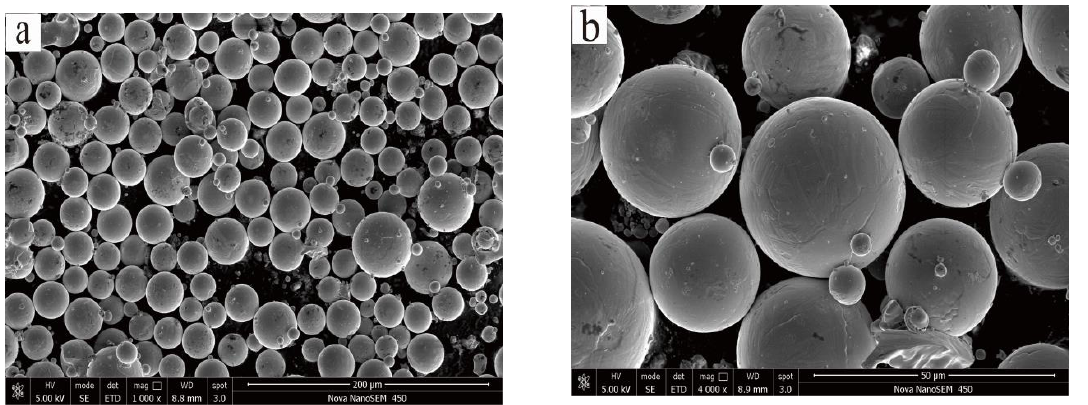
Figure 2. Scanning electron microscopy (SEM) images of the Ti-6Al-4V powders used for low magnification ( a ) and high magnification ( b ). Table 1. Chemical composition of the Ti-6Al-4V alloy powder